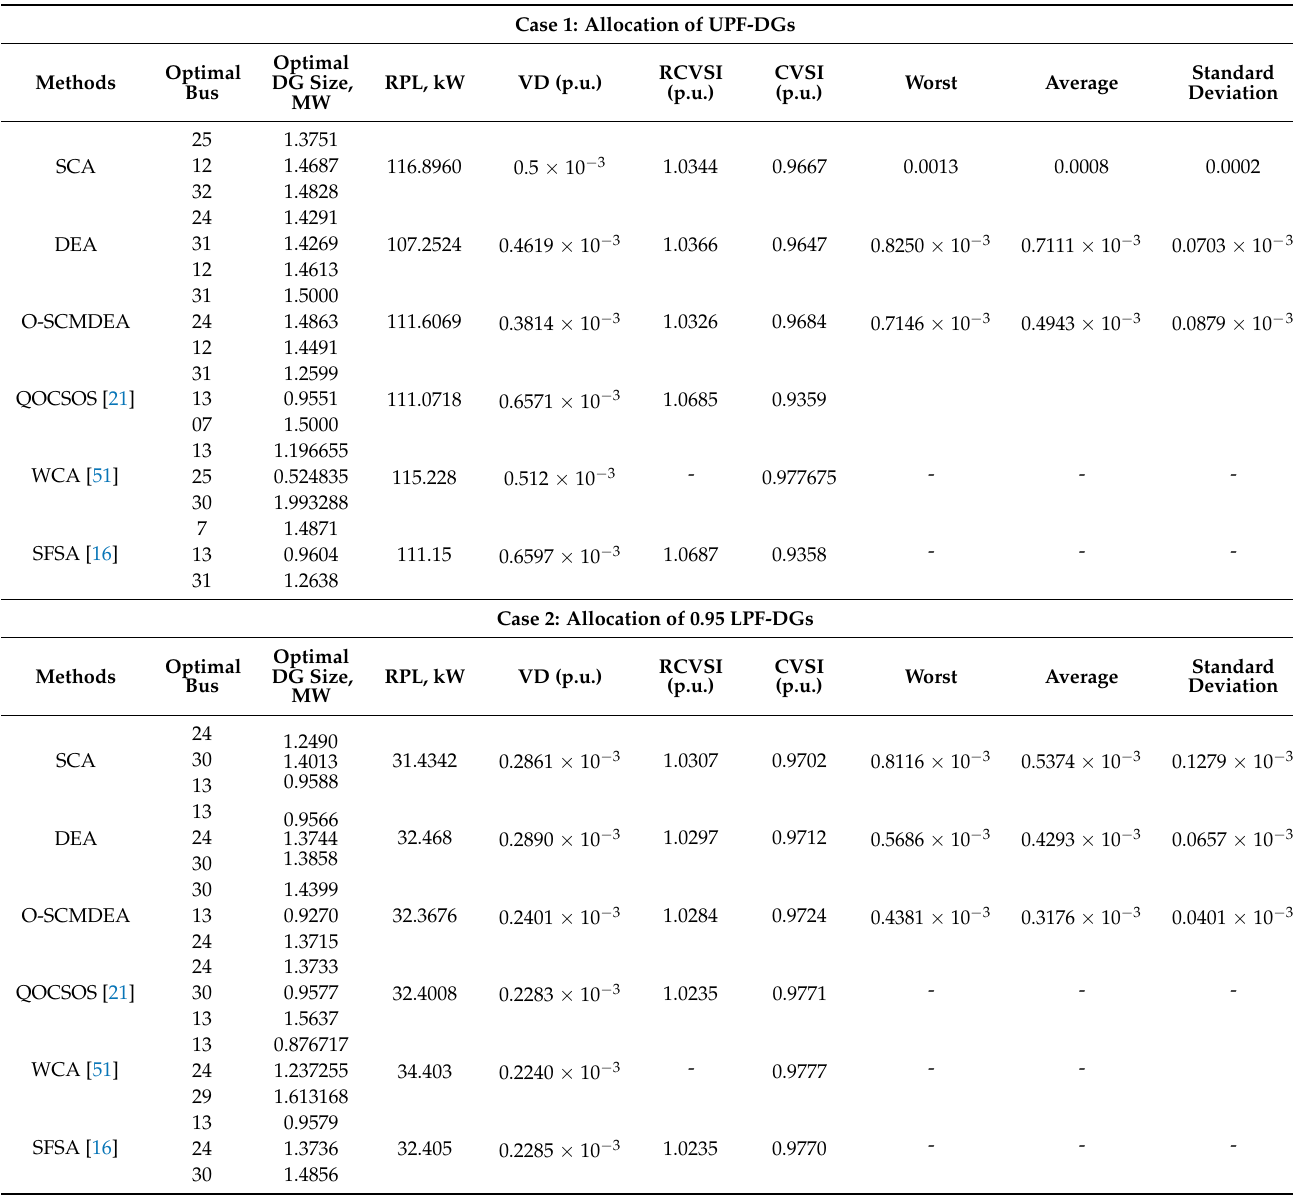
Table 5. Comparison of the results for the voltage deviation minimization of 33 bus